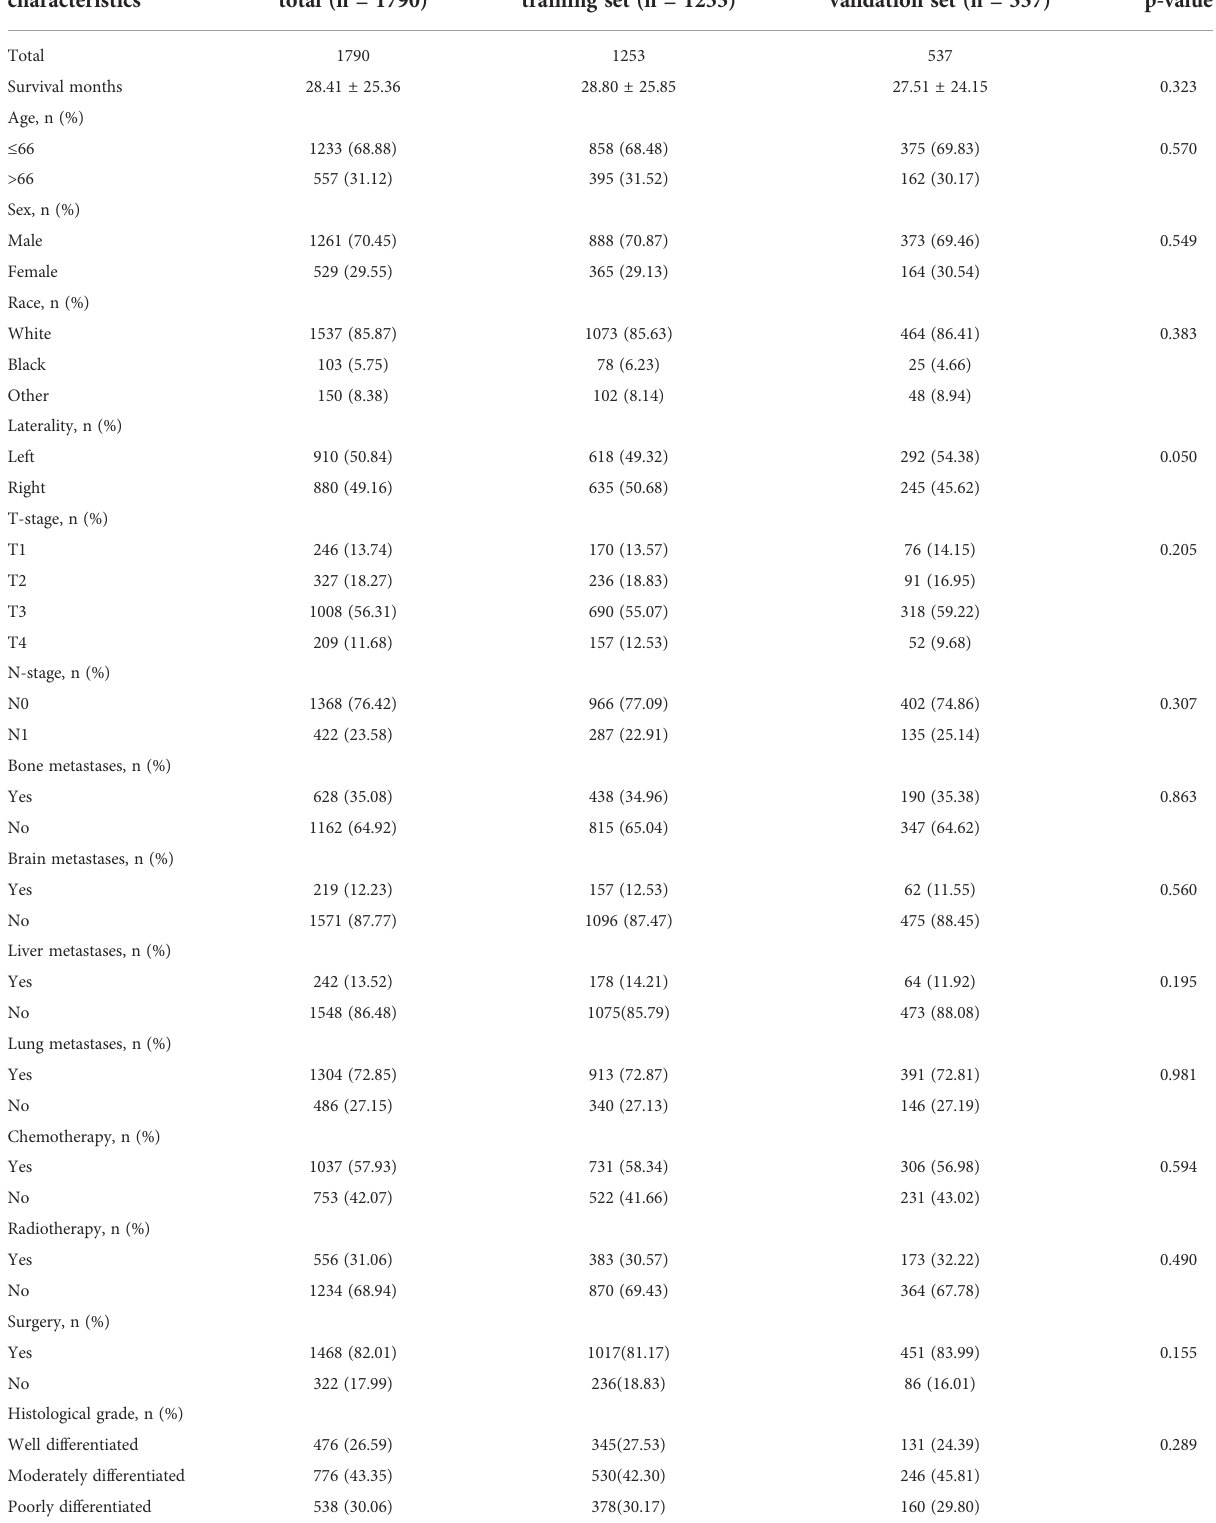
TABLE 1 Baseline demographic and clinical characteristics of patients in the training set and validation